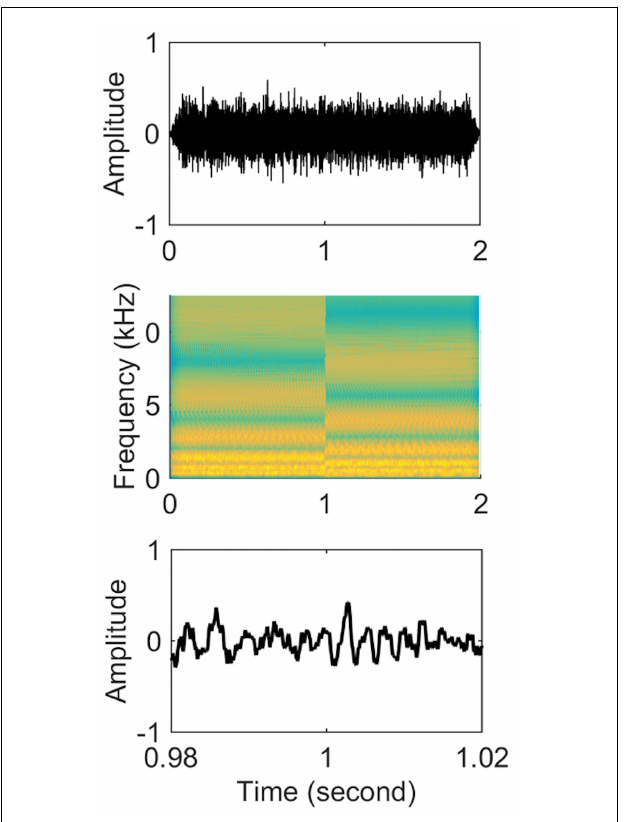
FIGURE 1 | Stimuli waveforms (upper panel) , spectrograms (middle panel) , and zoom-in of time-domain waveforms from 0.98 to 1.02 s (lower panel) for a standard-inverted stimulus. The ripple density was 1 ripple/octave for both